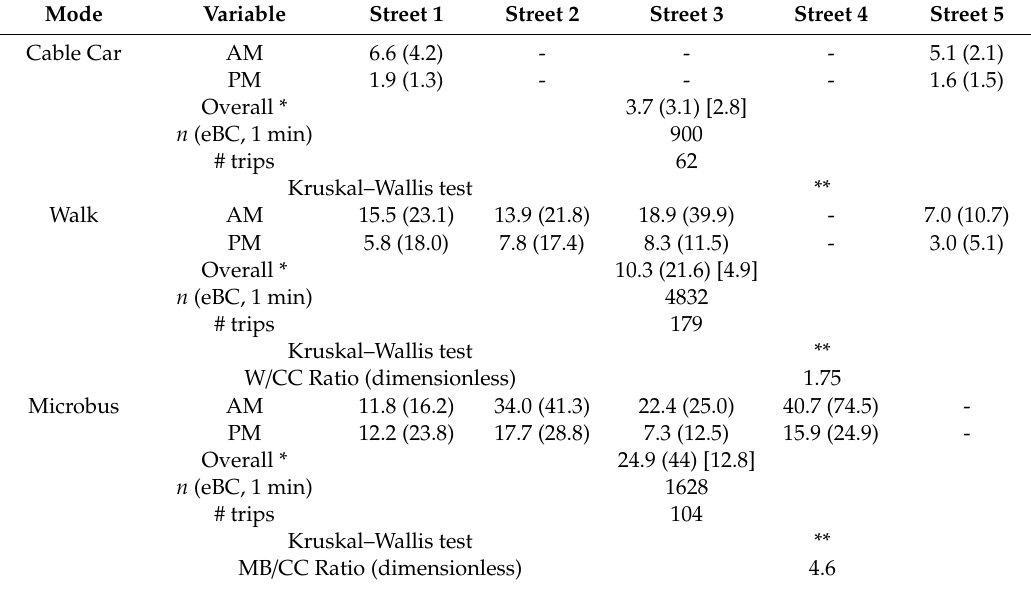
* Statistics over all streets and sampling periods (peak tra ffi c: AM, o ff -peak tra ffi c: PM). **: p -value < 0.05. The mean eBC exposure concentration inside the microbus was 24.9 µ g m − 3 range of variability (SD, 44 µ g m ). The lowest mean values (0.34 µ g m areas, while the highest were at intersections and bus stops (approx. 82 µ g m plot of eBC is available in Figure S1). Wiedensohler et al. [38] reported the mean and